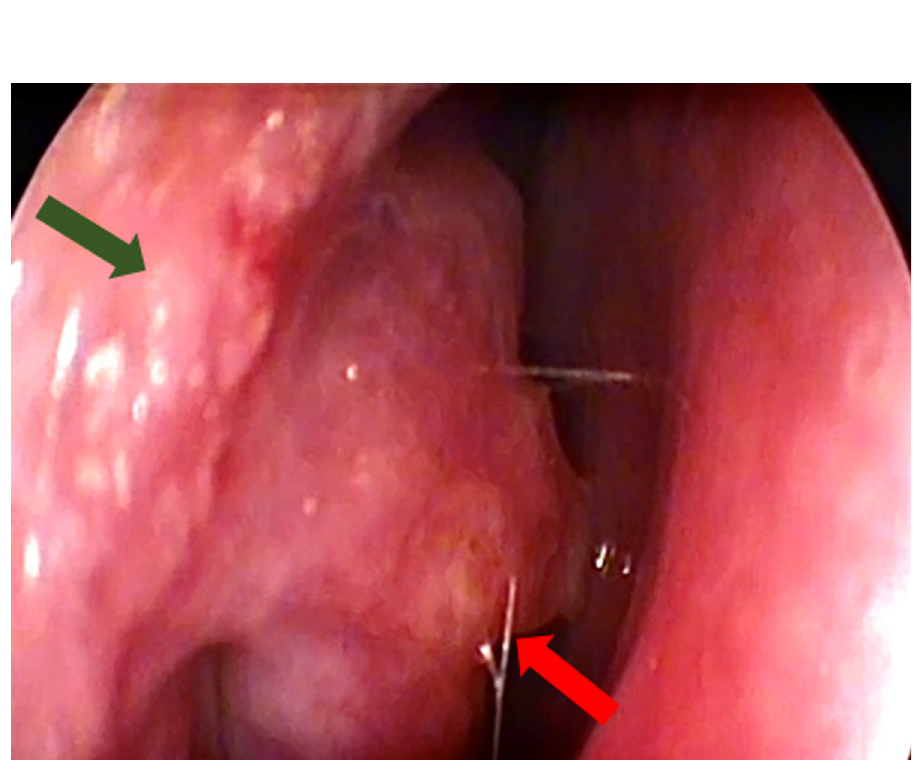
Fig 1. Manifestation of sporotrichosis in the nasal mucosa (isolated) of a patient (case 25) treated at the ENT outpatient clinic at INI/FIOCRUZ. Granular infiltration in the right nasal vestibule (green) and in the right inferior nasal turbinate (red). Source: Cla´udia Maria Valete (ENT outpatient clinic, INI/FIOCRUZ).